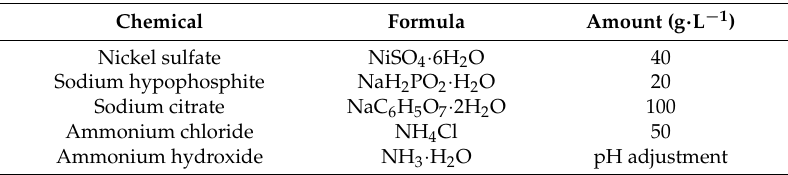
Table 1. Formulations of the Ni electroless plating bath.